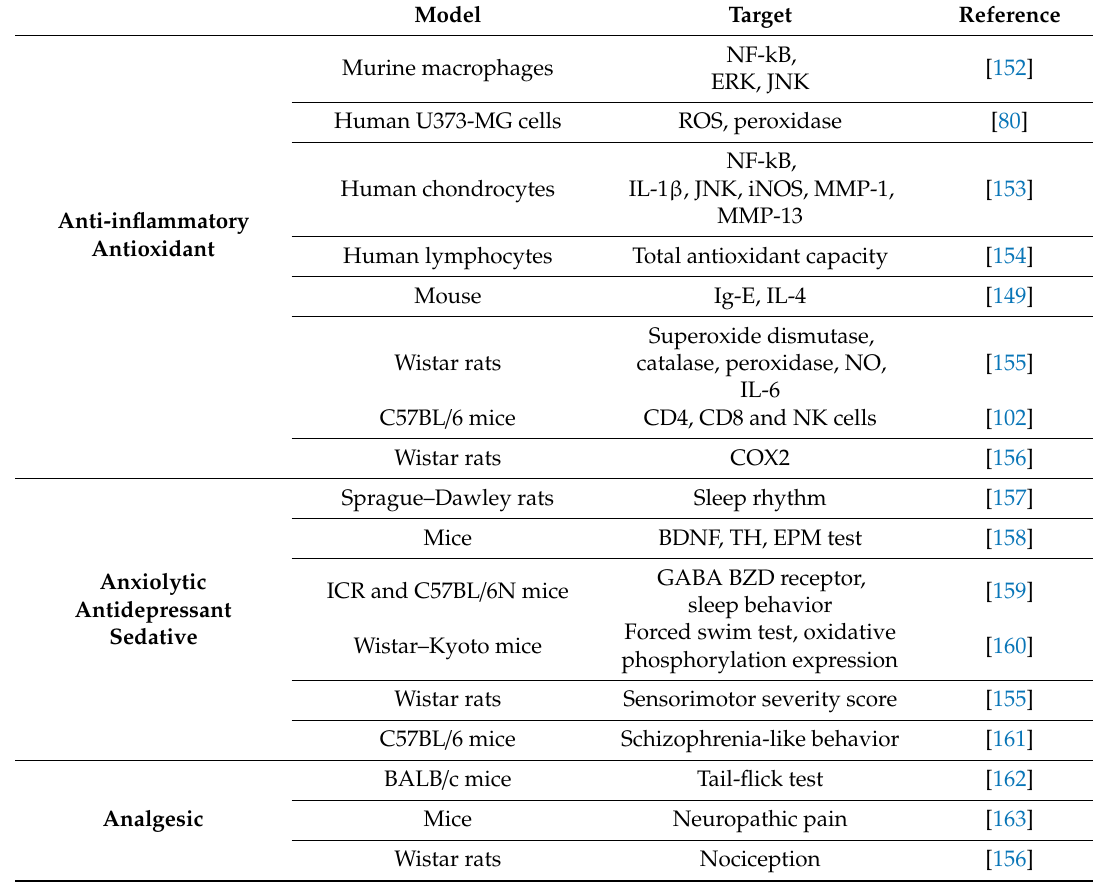
Table 8. Preclinical evidence of α -pinene biological